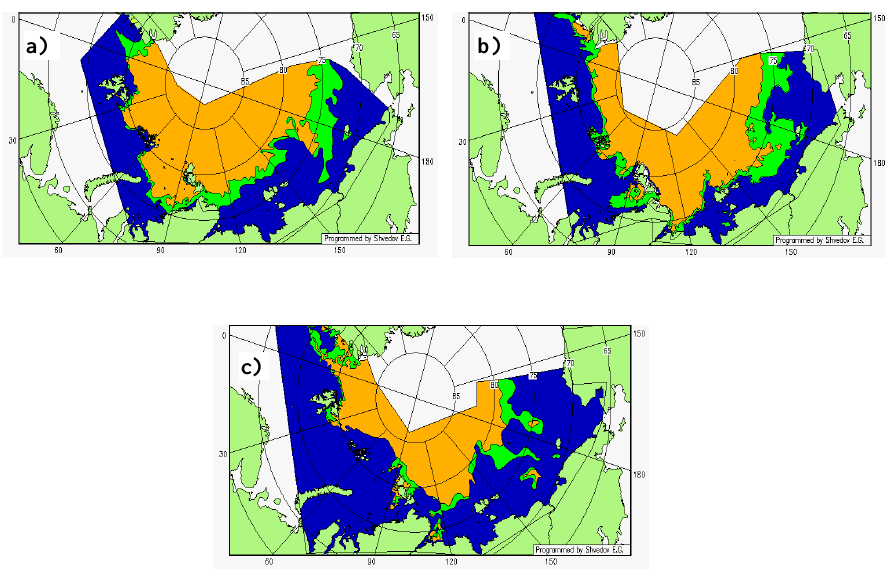
Fig. 4. Sea-ice extent in the Eurasian Arctic Seas during expeditions dated: September 2003 (a) , 2004 (b) , and 2008 (c) , from AARI data. Blue is open water, green is 1/10 to 6/10 ice coverage, and orange is 7/10 to 10/10 ice coverage.